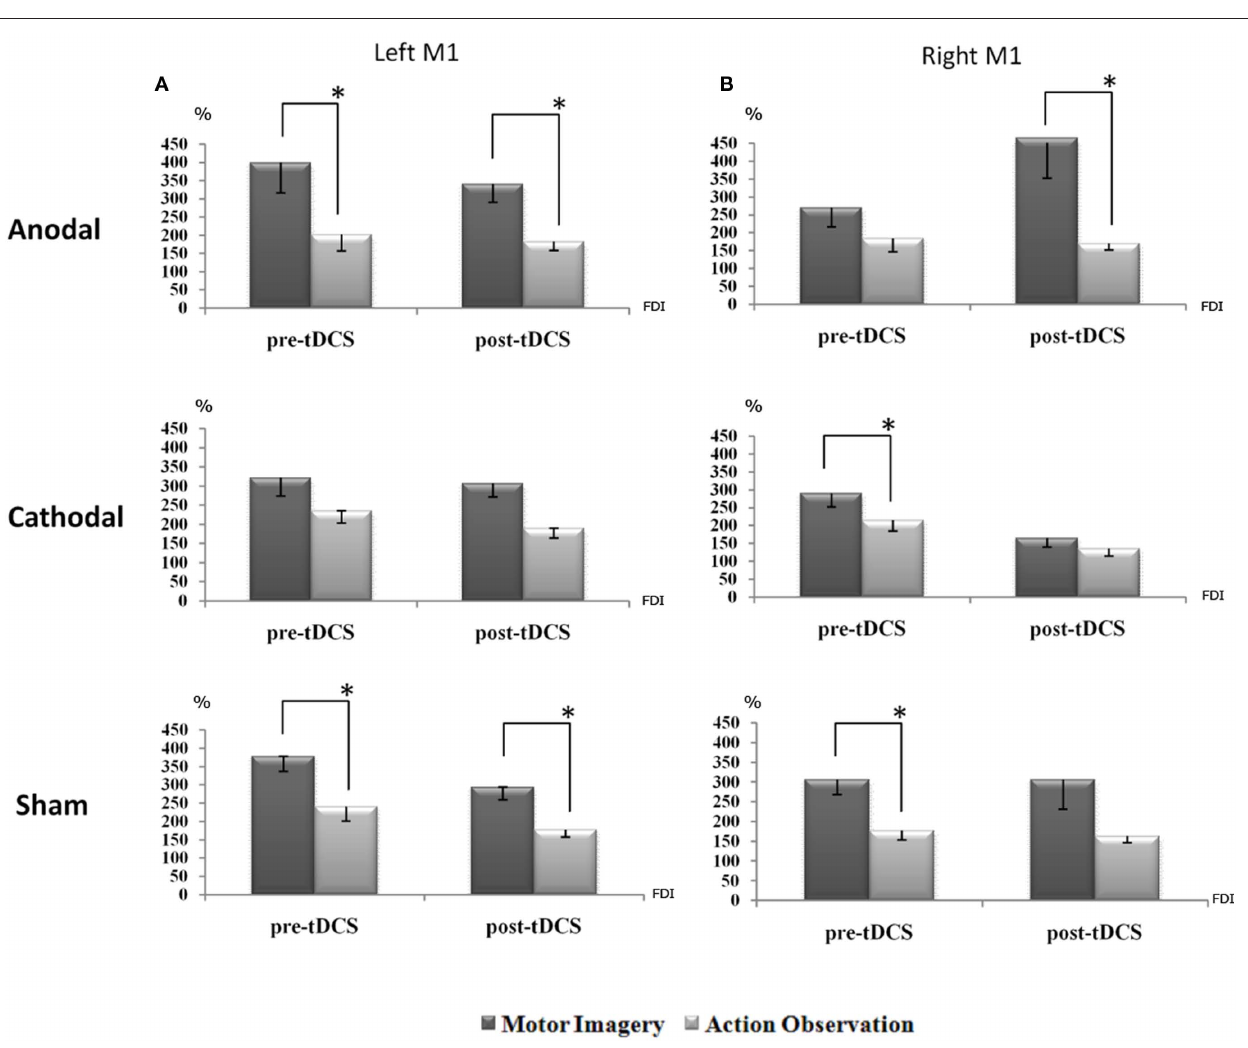
TMS is applied on the right hemisphere (B) , such an effect is again significant before sham and cathodal tDCS, and only after anodal tDCS. A value of 100% indicates, independently for each subject, the mean value during the baseline condition (before right PC tDCS). The error bars correspond to 1 SE. An asterisk (*) indicates significant differences between the